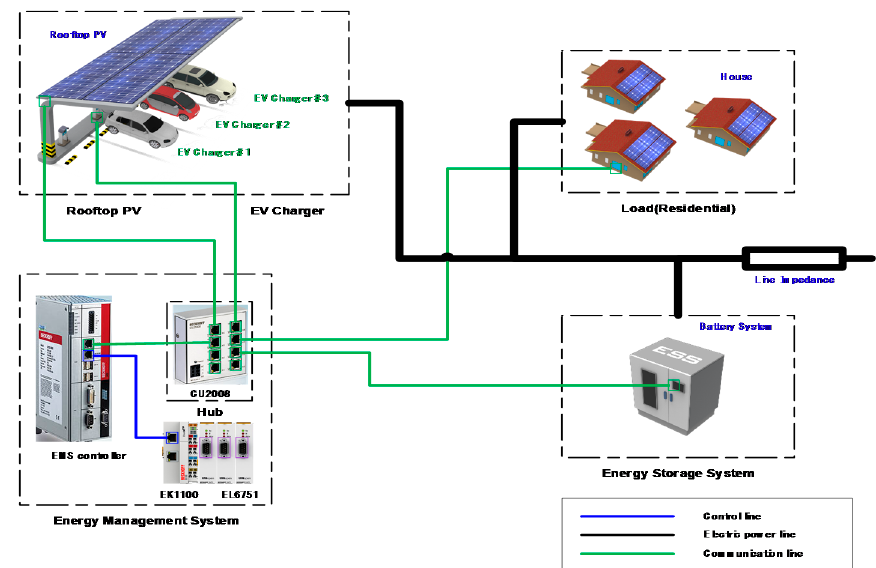
Figure 4. Configuration of the secondary feeder with electric vehicle (EV) infrastructure for the proposed method.